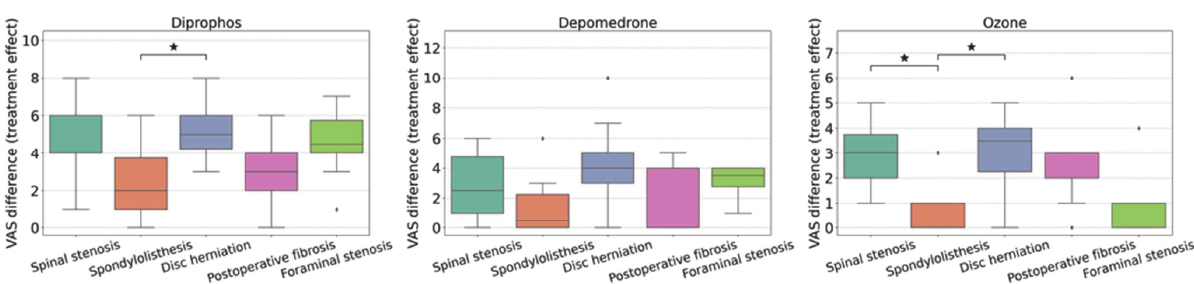
Fig. 3. Treatment effect (VAS change prior to and after therapy) for individual drugs and indications. The asterisks denote statisti- cally significant differences between the given